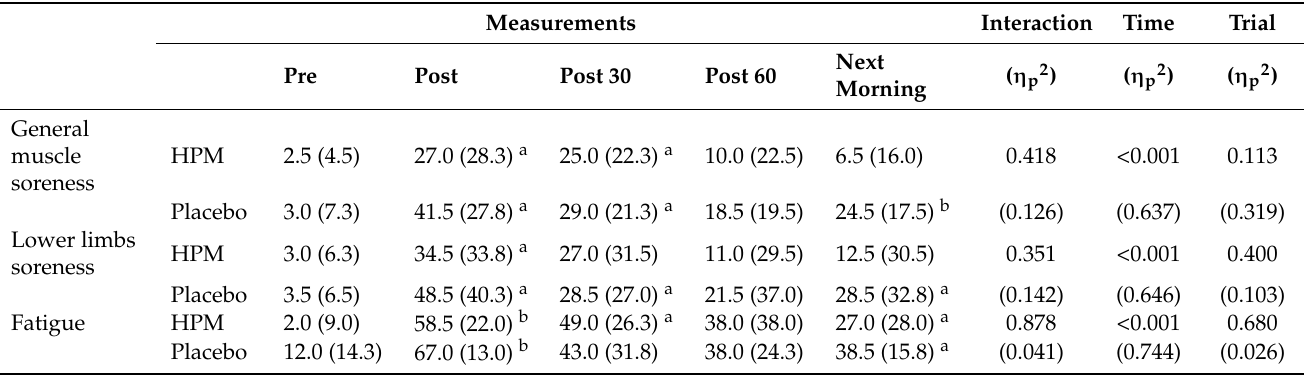
Table 1. Visual analog scale scores during trial.